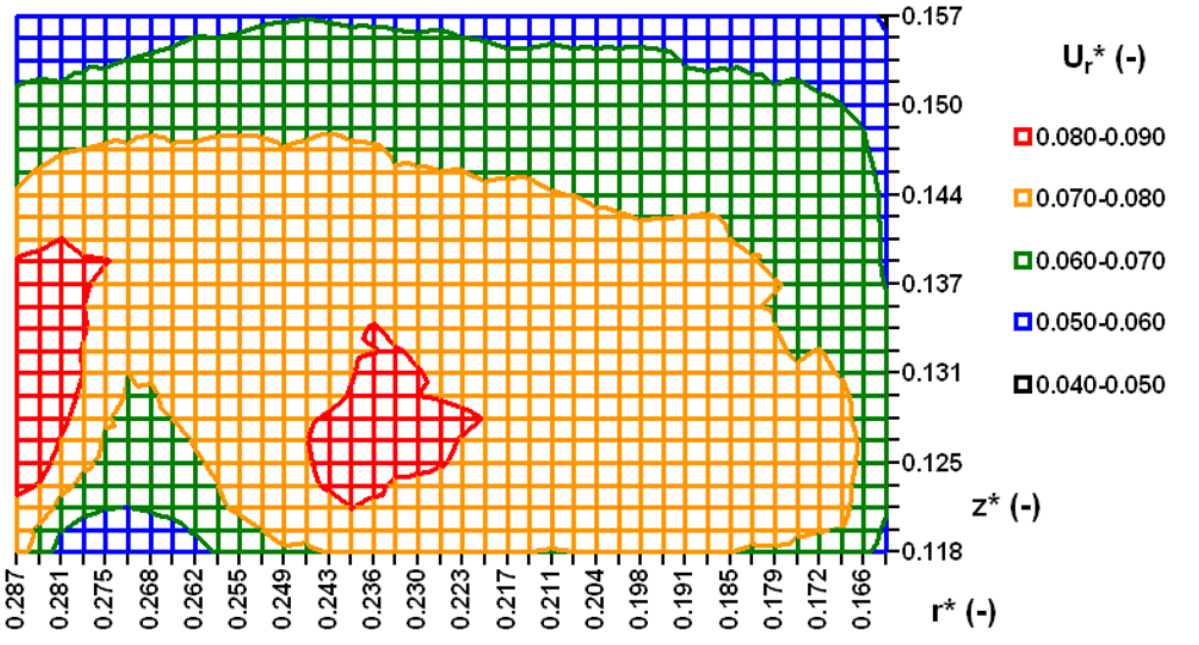
Fig. 2. Dimensionless radial mean velocity distribution U r* = )/( NDU